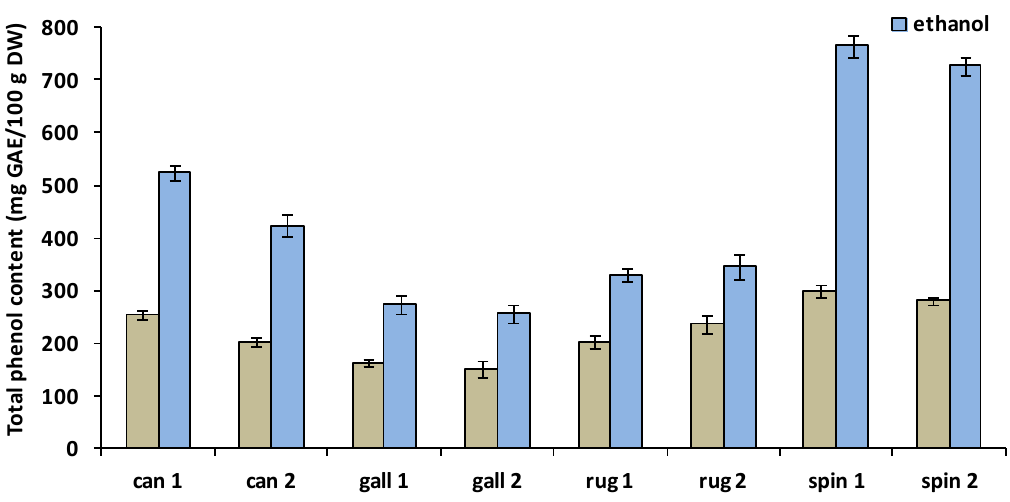
Figure 1. Total polyphenol content of water and ethanolic extracts of R. canina (can), R. gallica (gall), R. rugosa (rug) and R. spinosissima (spin); means ± SD; 1 = location 1 ( Gödöllő ), 2 = location 2 (Szeged). GAE: gallic acid equivalent; DW: dry weight.